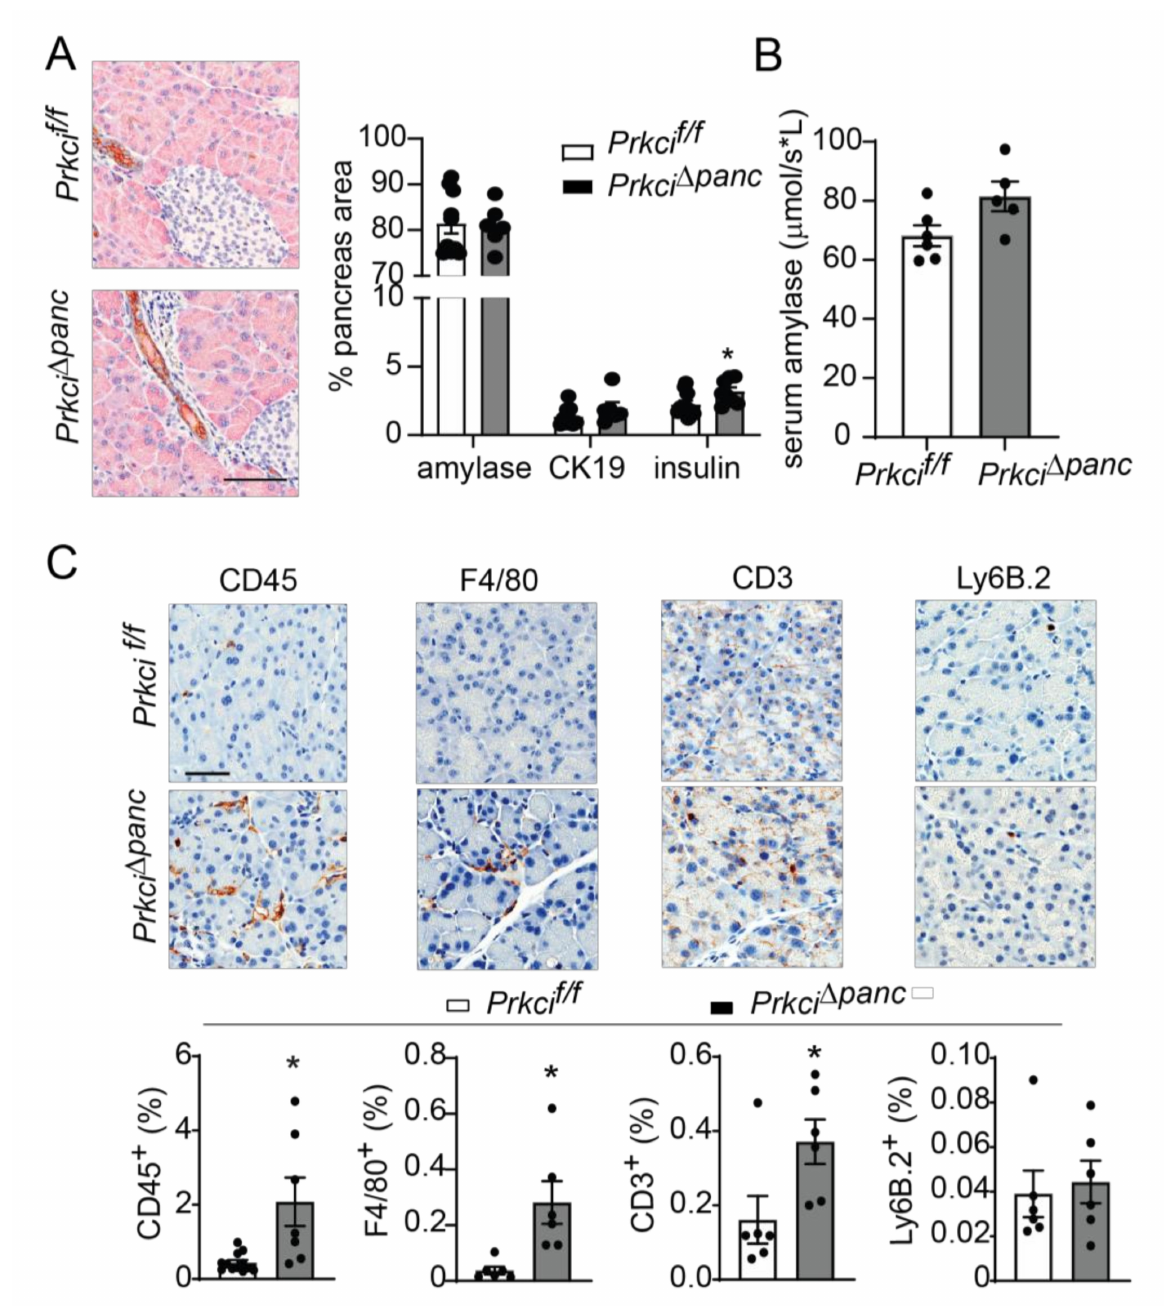
Figure 2. Ablation of pancreatic Prkci expression increases pancreas immune cell infiltration. ( A ) Representative image of IHC detection of acinar (amylase; pink) and ductal (cytokeratin-19, CK-19; brown) cell markers in the pancreata of 1.5 month old mice (scale bar = 100 µ m; left panel). Quantitation of area of IHC detection of amylase, CK19, and insulin is plotted as mean ± SE; n ≥ 6 (right panel). ( B ) Basal serum amylase level in 3.5 month old mice ( n = 6, 5, respectively) is plot- ted as mean ± SE. ( C ) Representative images of IHC detection of infiltrating leukocytes (CD45 + ), macrophages (F4/80 + ), T-cells (CD3 + ), and neutrophils (Ly6.B + ) in pancreata of 1.5 month old mice (scale bar = 50 µ m). Quantitative analysis of IHC staining is plotted below images as mean ± SE; n ≥ 6. * p < 0.05 compared to Prkci f/f